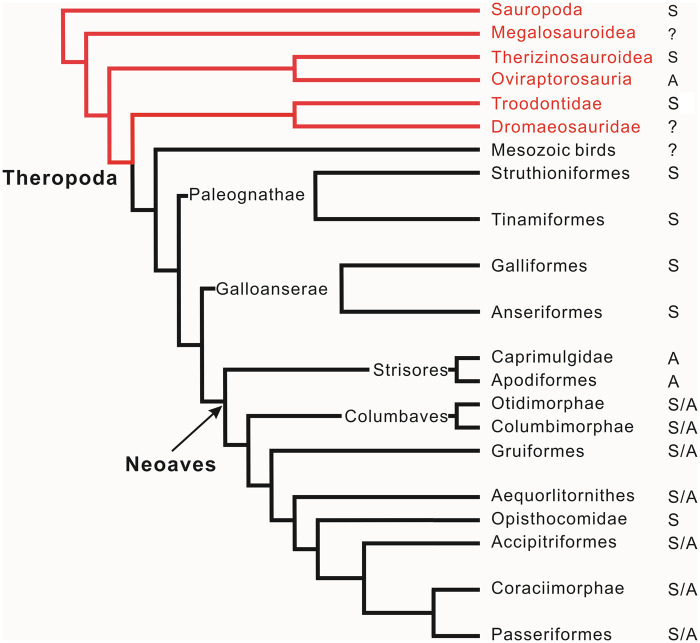
Distribution of hatching modes (S, synchronous; A, asynchronous) among saurischian dinosaurs based on the fossil record for non-avian dinosaurs and on ornithological observations for birds (Stoleson and Beissinger 2010). The phylogeny was compiled by integrating the avian phylogeny (black) based on Prum et al. (2015) and a general dinosaur phylogeny (red) based on Varricchio and Jackson (2016).